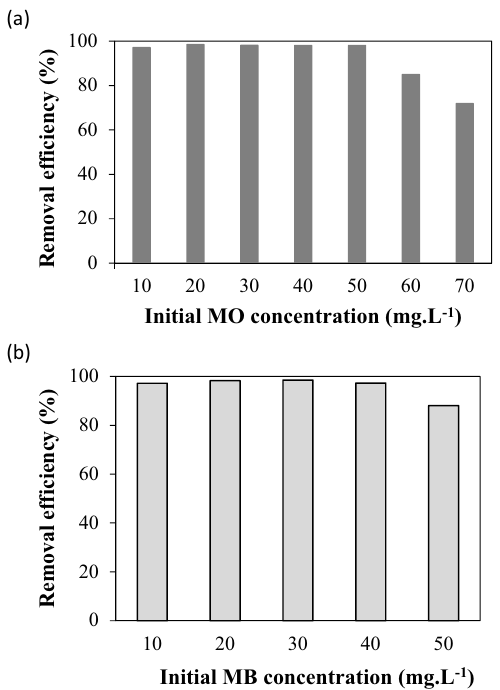
Figure 5: E ff ect of initial concentration of ( a ) MO and ( b ) MB on the removal e ffi ciency. MO: initial pH 7.0, catalyst dosage = 100 mg · L − 1 , [ H ] = 0.2 mg · L − 1 , time = 60 min, and ambient temperature. MB: 2 O 2 initial pH 3.0, catalyst dosage = 50 mg · L − 1 , [ H 2 O 2 ] = 0.1 mg · L − 1 , time = 60 min, and ambient temperature.